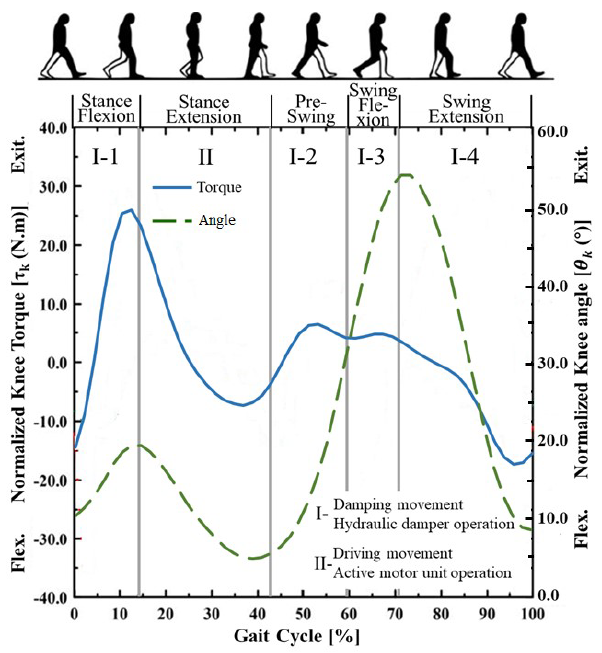
Figure 6. Normalized knee torque and knee angle as inputs to the simulation target.